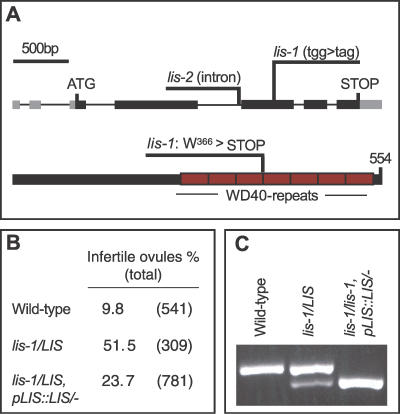

LIS Codes for a WD40 Repeat Protein(A) Gene (upper panel) and protein (lower panel) structure of LIS. The localization of the lis-1 and lis-2 mutations and the seven WD40 repeats are indicated.(B and C) LIS cDNA driven by a 2.6-kb upstream promoter complements the gametophytic (B) as well as possible sporophytic defects of lis-1/lis-1 mutants, allowing for the generation of homozygous plants, as demonstrated by PCR-based genotyping (C).